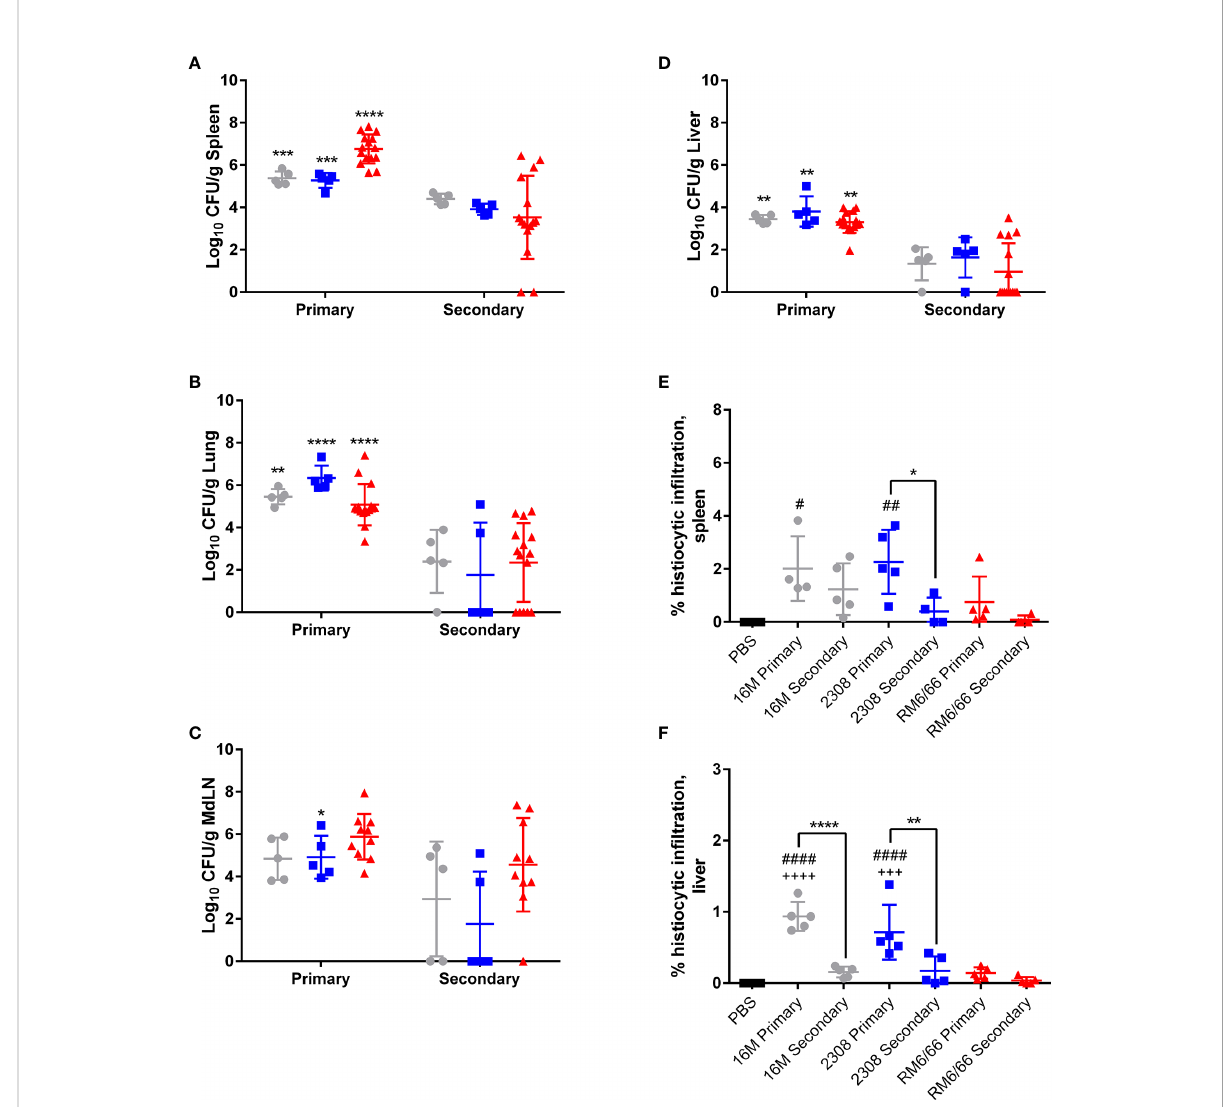
FIGURE 5 Previous infection protects mice against secondary intratracheal challenge with B . canis, B. abortus , or B . melitensis. Colonization following inoculation of female C57BL/6J mice with 10 7 CFU B . melitensis, B abortus , or B . canis in the (A) spleen, (B) lungs, (C) mediastinal lymph node (MdLN), and (D) liver. Data points represent the mean bacterial recovery in CFU per gram of tissue plus the standard deviation for all animals in each infection group 2-weeks following primary infection or secondary challenge. Data were analyzed using two-way ANOVA with Sidak ’ s multiple comparisons test. Quanti fi cation of % histiocytic in fi ltration within the (E) spleen and (F) liver at 2-weeks post-infection. Data were analyzed via one-way ANOVA and Tukey ’ s multiple comparisons test. Signi fi cant differences are depicted between infection groups (*p < 0.05, **p < 0.01, ***p < 0.001, ****p < 0.0001) and between infection groups and the PBS negative control group (##p < 0.01, ####p <